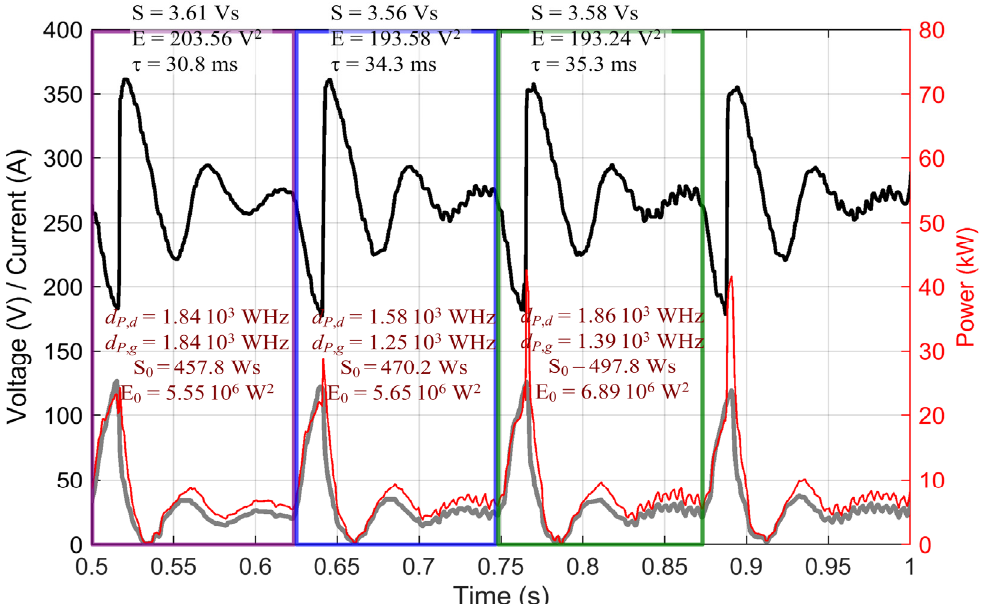
Figure 12. PPL profile with periodic pulsation and superposed ripple (elaborated from [154]): voltage (black) and current (grey) use the left axis, power (red) uses the right axis. Calculation of metrics for three consecutive periods: top black are for the voltage profile V ( t ) ( S , E , and τ with the prime indicating subtraction of the steady state value V dc ), middle brown for the power trajectory P P ( t ) (metric d P calculated using “difference” of adjacent samples, d P,d , and “gradient”, d P,g , a central difference where samples are separated by an empty place; metrics S and E applied to P P ( t ) as a network quantity, having subtracted the steady value for each